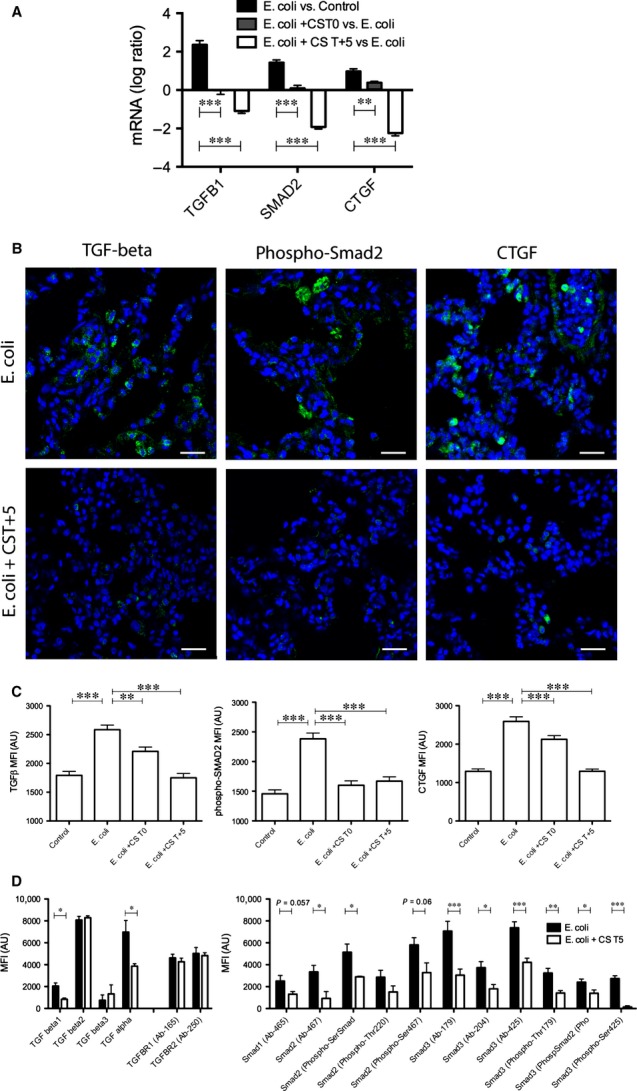
Immunolocalization and semi-quantitative analysis of fluorescence intensity in lung tissue stained for proteins contributing to fibrosis via transforming growth factor-beta (TGF-β) signalling. (A) Log ratio representation of qPCR analysis of TGF-B1, SMAD2 and CTGF transcripts in Escherichia coli versus healthy controls and animals treated with compstatin at T0 or T+5, versus untreated septic animals. Expression values were normalized by housekeeping gene β-actin. Data are shown as mean ± S.E.M., n = 3; one-way anova with Dunnett's multicomparison test. **P < 0.01, ***P < 0.001 as compared to E. coli versus Control ratio. (B) Immunostaining for TGF-β, phospho-Smad2/Smad3, and CTGF (columns) in the lungs of septic baboons (E. coli) versus compstatin-treated baboons at T+5 (E. coli + CS T+5) (rows). Magnification: bars, 50 μm. (C) Histogram representations of mean fluorescence intensity (MFI) of images collected for the above-mentioned proteins as detailed in Figure1. Data are shown as means ± S.E.M.; one-way anova with Dunnett's multicomparison test. ***P < 0.001 as compared to the E. coli group. (D) Phospho-antibody array analysis. MFI of the antibody spots are presented as means ± S.E.M. of six replicates per experimental condition with unpaired two-tailed t-tests. *P < 0.05; **P < 0.01; ***P < 0.001.